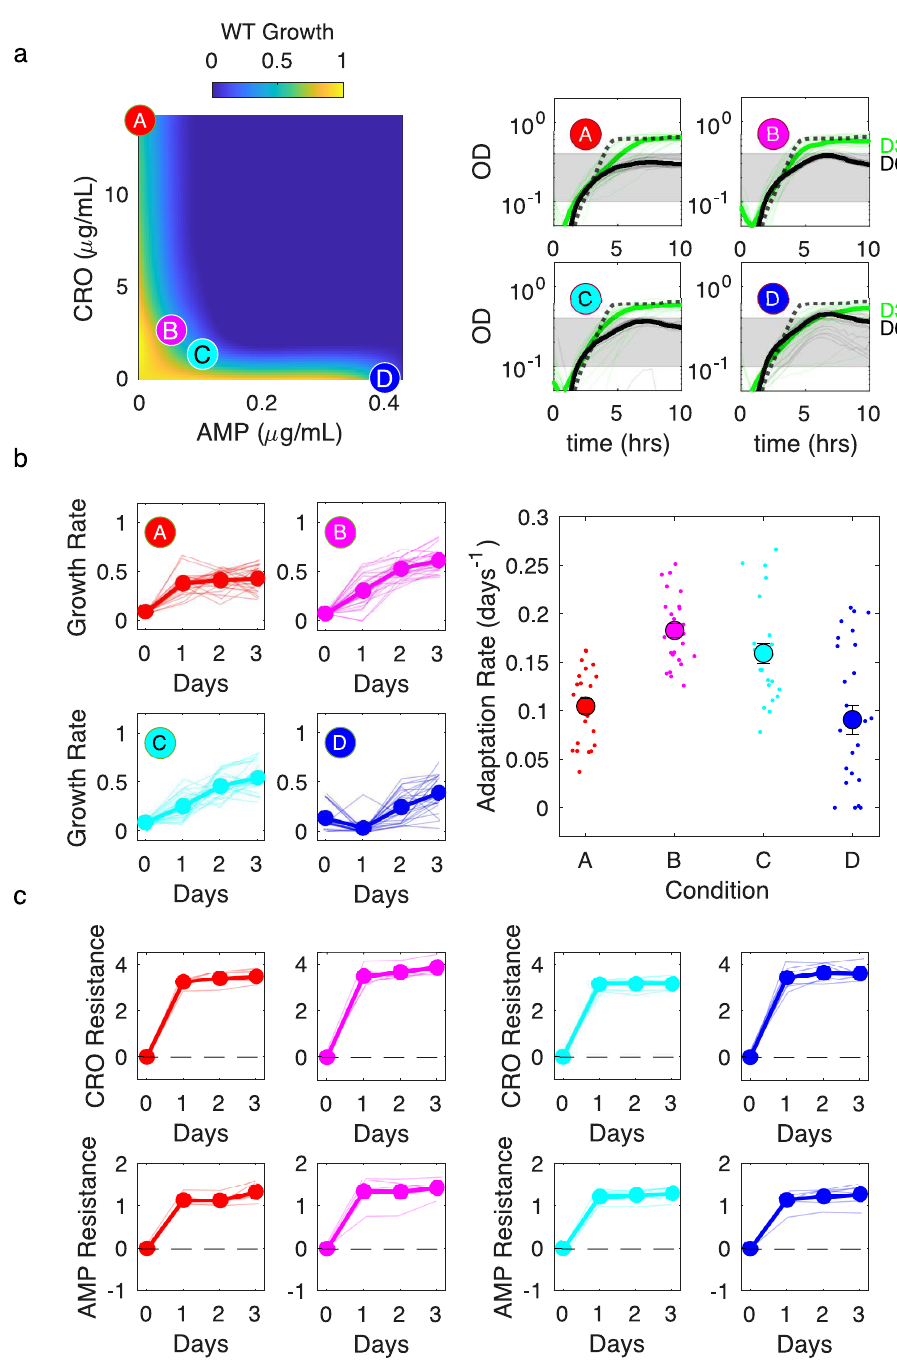
Fig 1. Dual β -lactam combination accelerates growth adaption but selects for similar resistance levels to component drugs. a) Left panel: per capita growth rate of ancestral populations as a function of ampicillin (AMP) and ceftriaxone (CRO) concentrations. Circles correspond to different selecting conditions along a contour of constant inhibition. Drug concentrations (AMP,CRO) are (0, 48) (red, A); (0.05, 2.6) (magenta, B); (0.10, 1.3) (cyan, C); and (0.43, 0) (blue, D). The latter point is shifted for visualization. Right panels: growth curves for the first (black) and last (green) days of evolution for each condition. Dashed lines are drug-free growth curves in ancestor strains. Shaded region is OD range over which per capita growth rate is estimated. b) Left panels: per capita growth rate over time for each condition. Right panel: average rate of growth adaptation over the course of the evolution. Adaptation rate in the single drug conditions (red and blue conditions, combined) is less than that in the combined drug conditions (magenta and cyan, combined), 1-sided t-test (unequal variance), p < 10 − 4 . Error bars are ± standard error of the